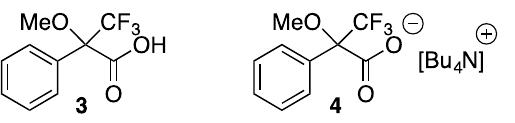
Figure 2. Mosher’s acid ( 3 ) and its n -Bu 4 N salt ( 4 ).